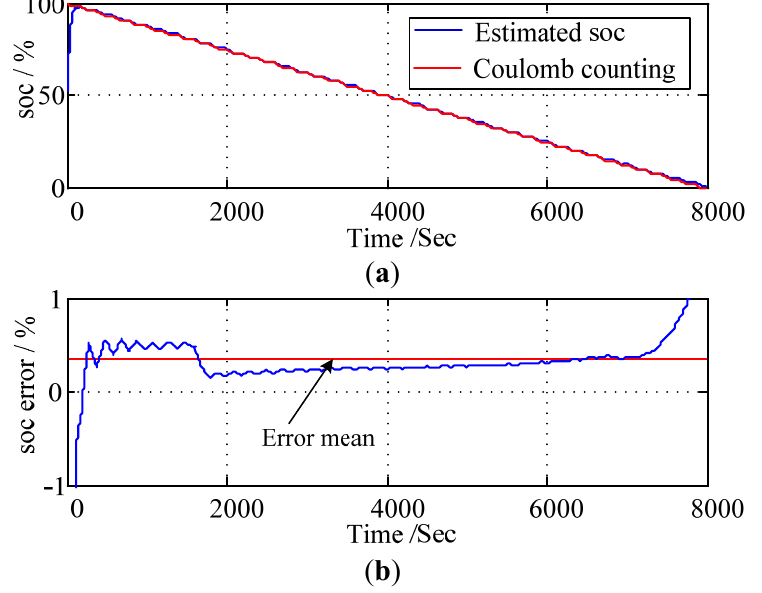
Figure 16. The estimation results and their error: ( a ) SOC estimation results; ( b ) SOC estimation